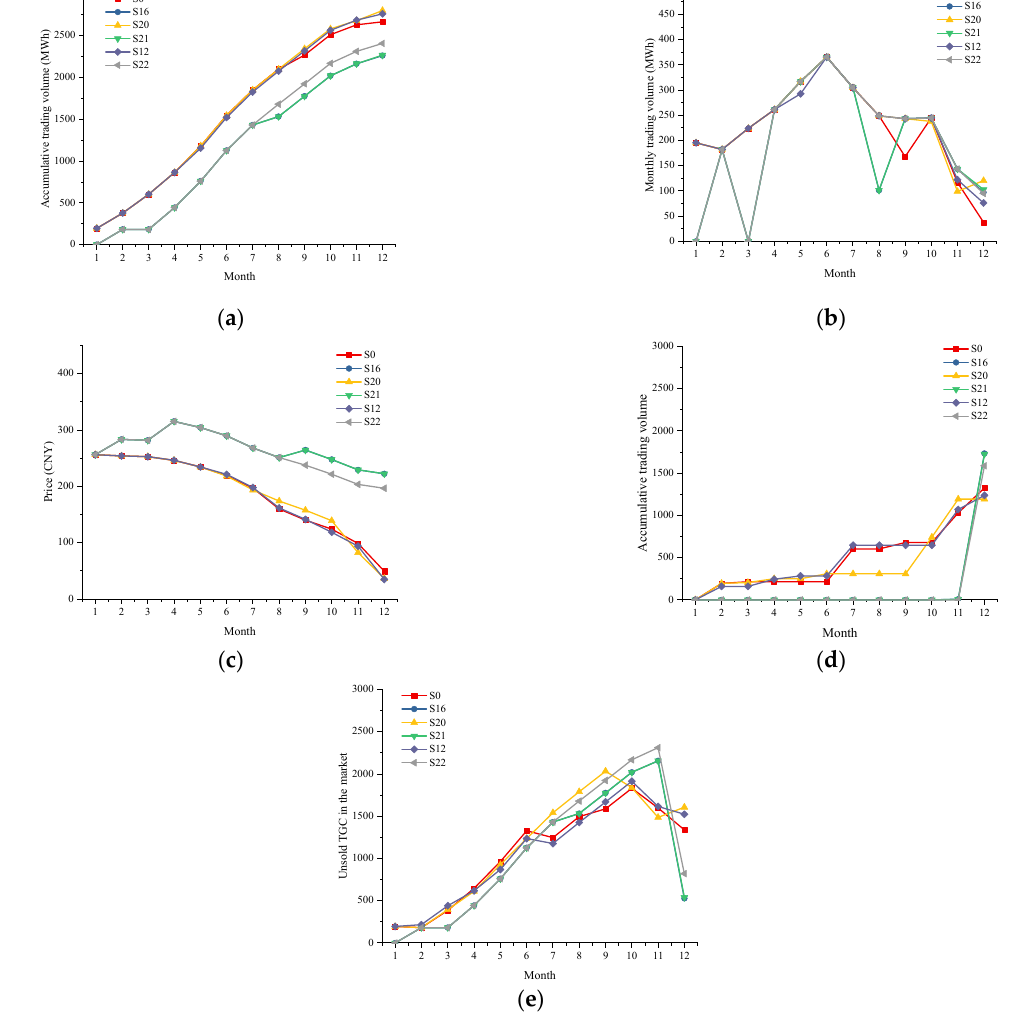
Figure 13. Trends of decision-making and market performance under different discount factors and penalties. ( a ) Accumulative renewable-power trading volume. ( b ) Monthly renewable-power trading volume. ( c ) TGC price. ( d ) Accumulative TGC trading volume. ( e ) Accumulative unsold TGCs.